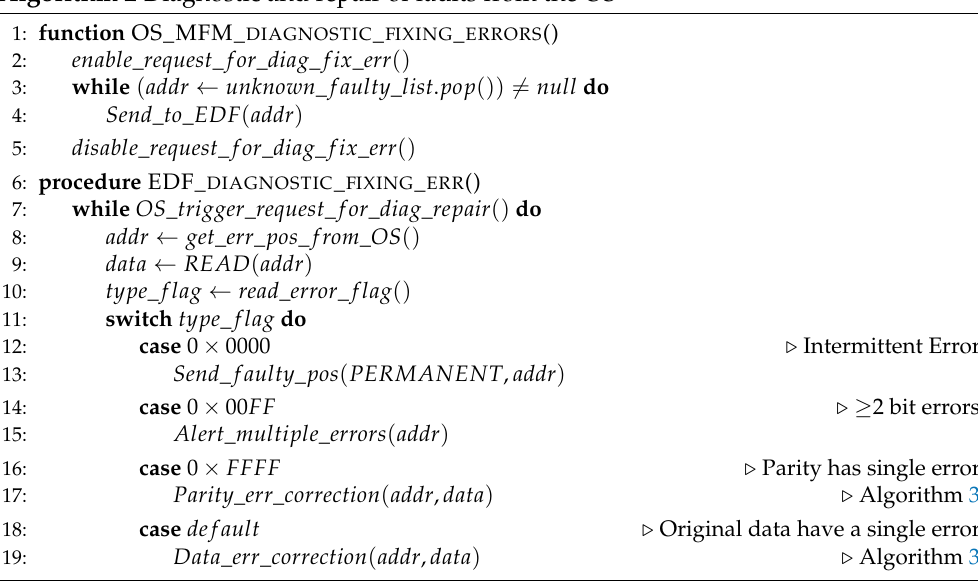
Algorithm 2 Diagnostic and repair of faults from the